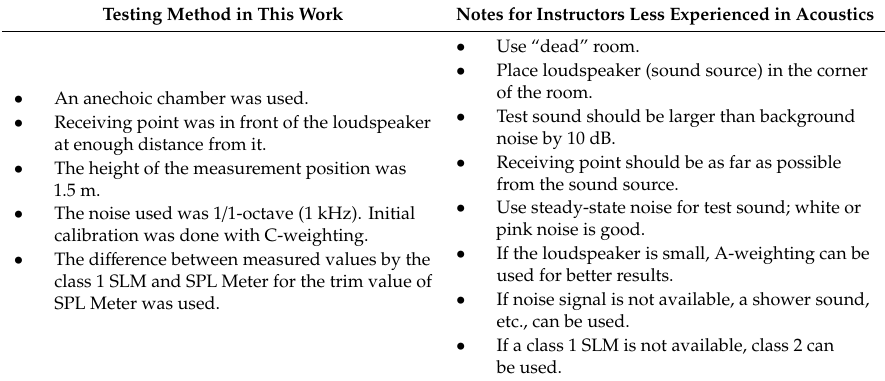
Table A1. Suggested method of calibration (summarized from previous work